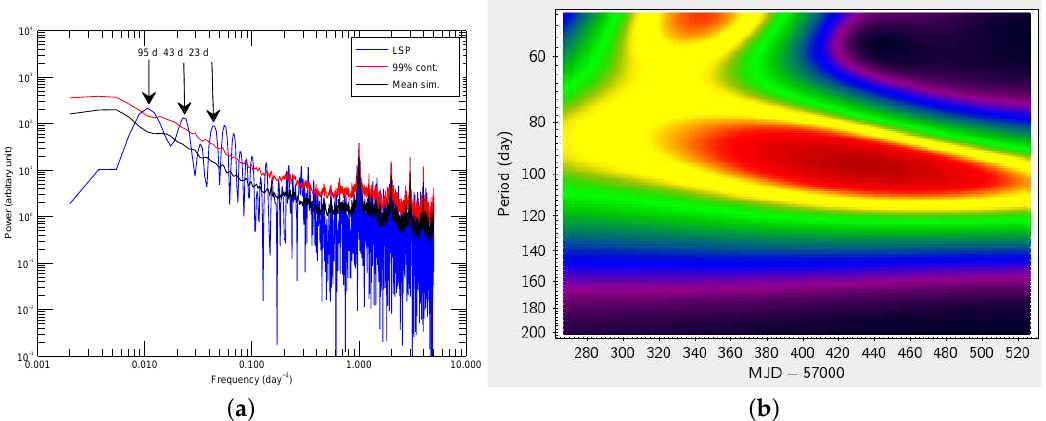
Figure 3. ( a ) Left panel: Lomb-Scargle periodogram (LSP) of the 2015/2016 data (blue line). The 99% confidence level is shown as the red contour; ( b ) Right panel: the resulting graph from the wavelet Z-transform